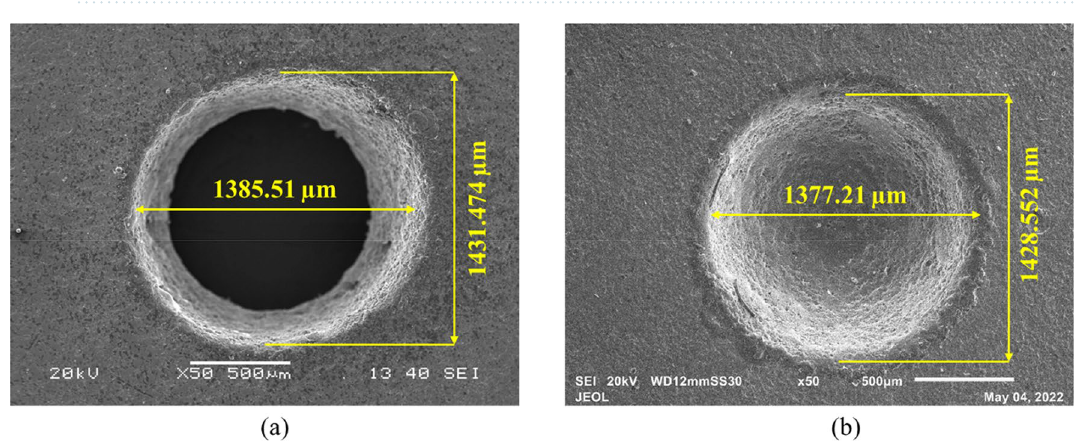
Figure 12. Micrographs of the machined microhole at ( a ) 80 V, 30 wt%, and 50% DF and ( b ) 80 V, 30 wt%, and 70%